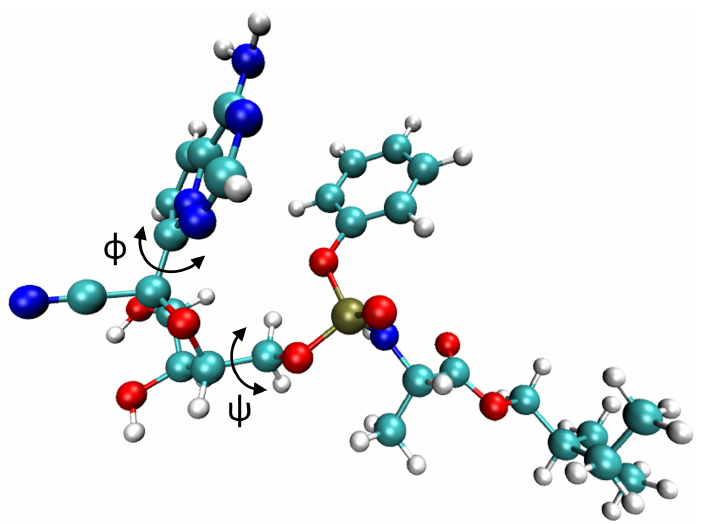
Figure 4. Molecular structure of remdesivir, which is composed of 77 atoms. The two dihedral angles, φ and ψ , are used to bias and analyze our calculations. The H, C, N, O, and P atoms are shown in white, cyan, blue, red, and yellow,